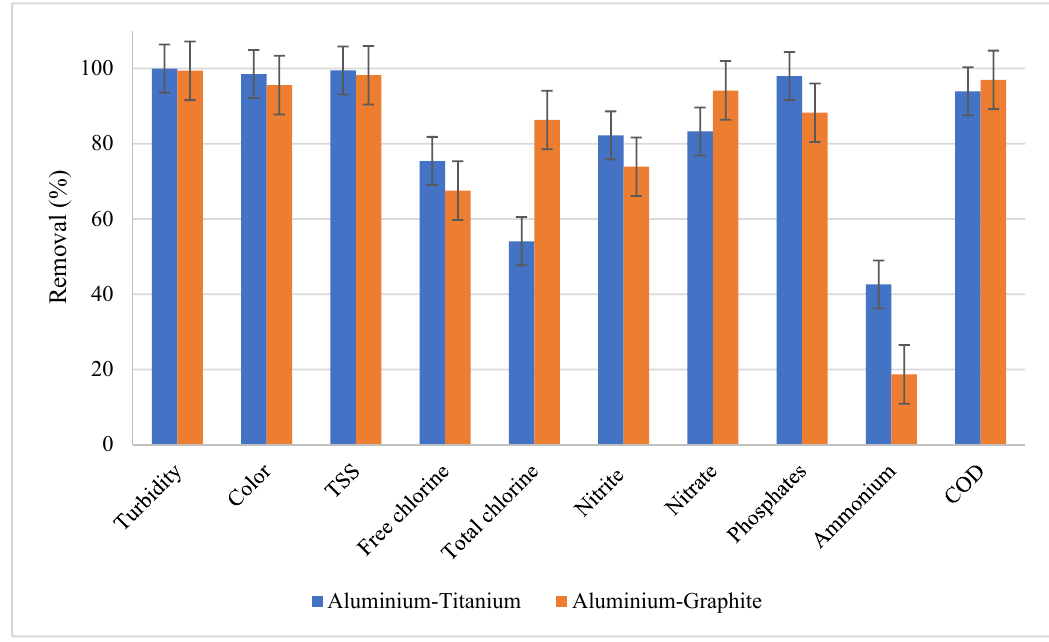
Figure 4. Removal efficiencies of the Al–Ti and Al–Gr combinations. Figure 4. Removal e ffi ciencies of the Al–Ti and Al–Gr